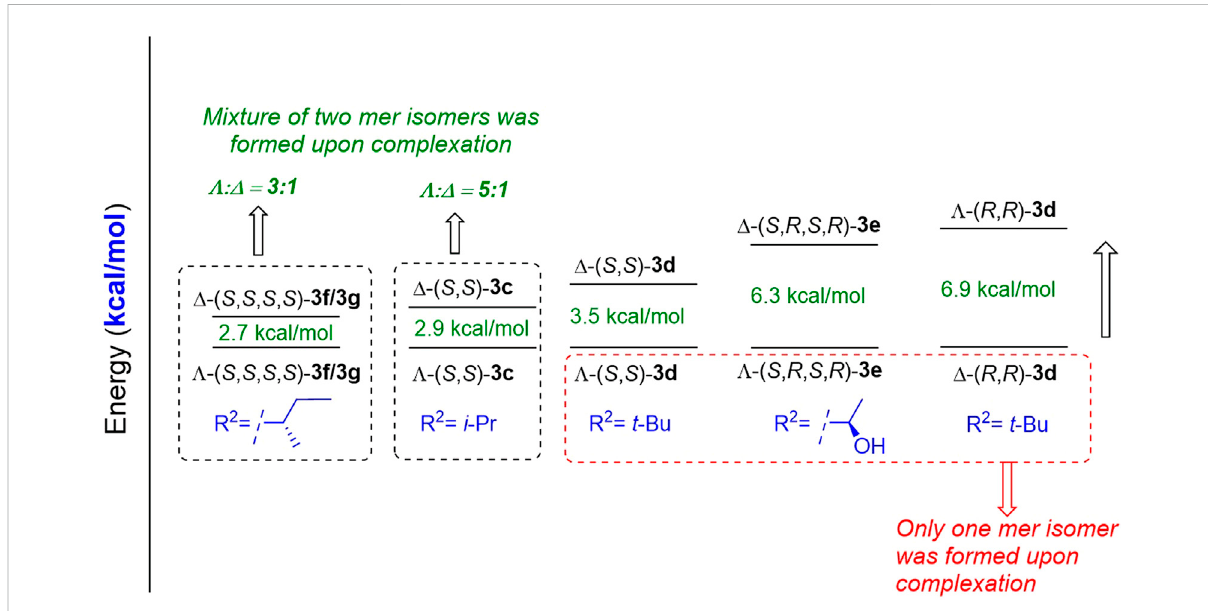
FIGURE 1 Diastereoselective complexation of octahedral cobalt